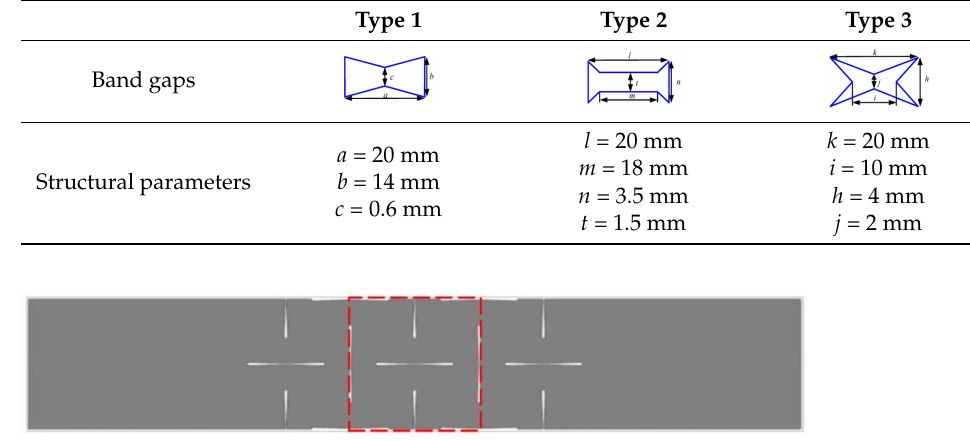
Figure 4. Finite element method